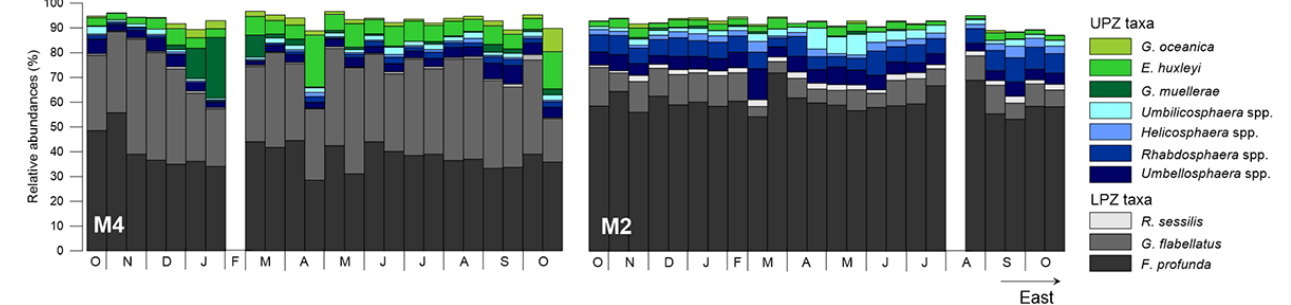
Figure 5. Percentage of the most abundant coccolithophore taxa ( > 2%) at stations M4 and